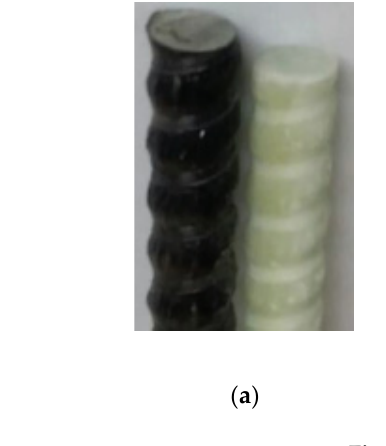
Figure 3. FRP rebar and tensile test: ( a ) Surface of GFRP and BFRP; ( b ) Test set up for tensile test; ( c ) Failure mode of FRP rebar. Table 3. Typical material properties of GFRP and BFRP reinforcing